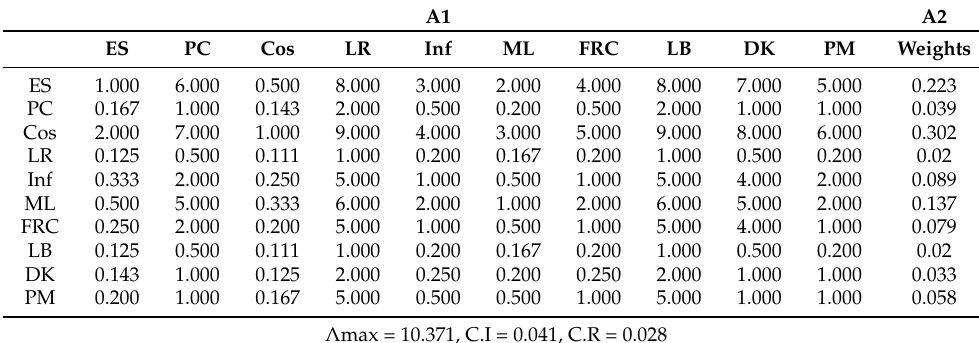
Table A1. Case study-2: Pairwise comparison of criteria.